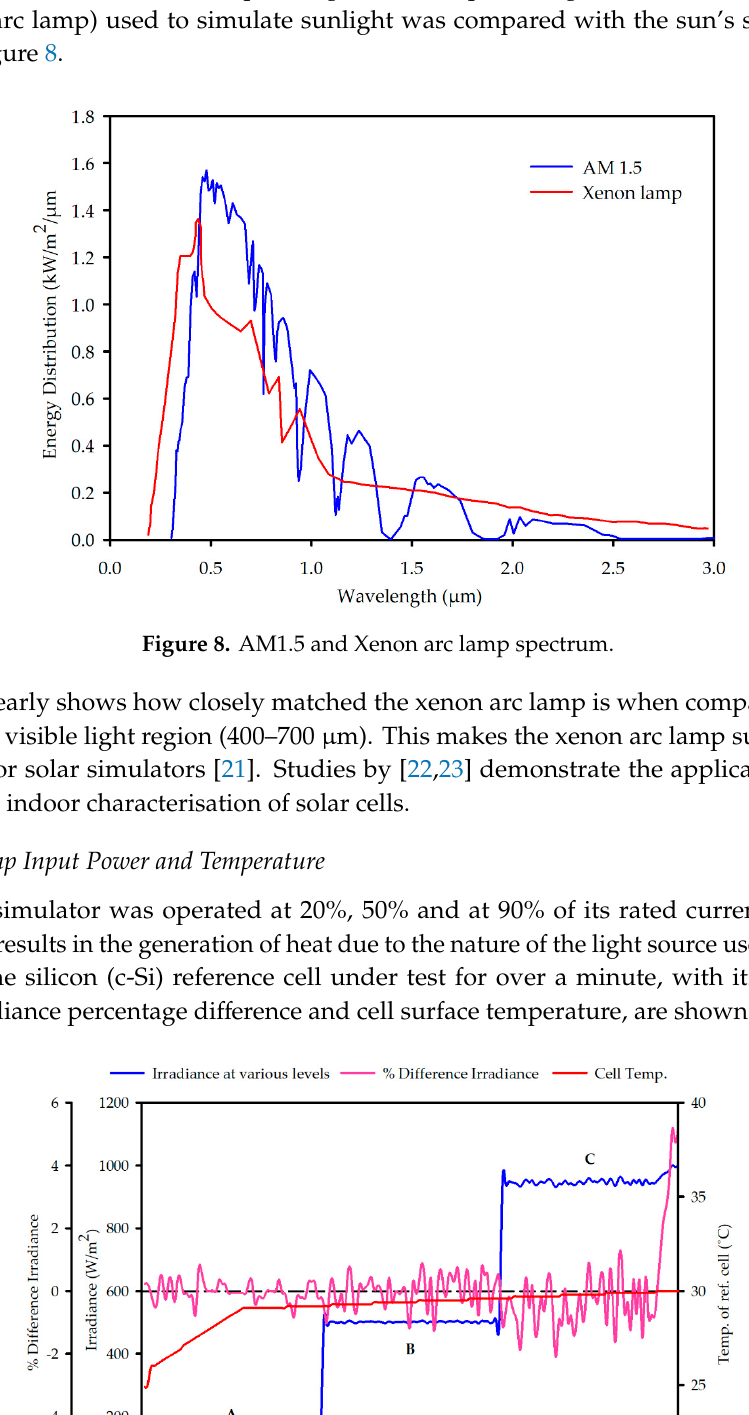
Figure 9. Solar simulator operated at varying set points of its rated current.